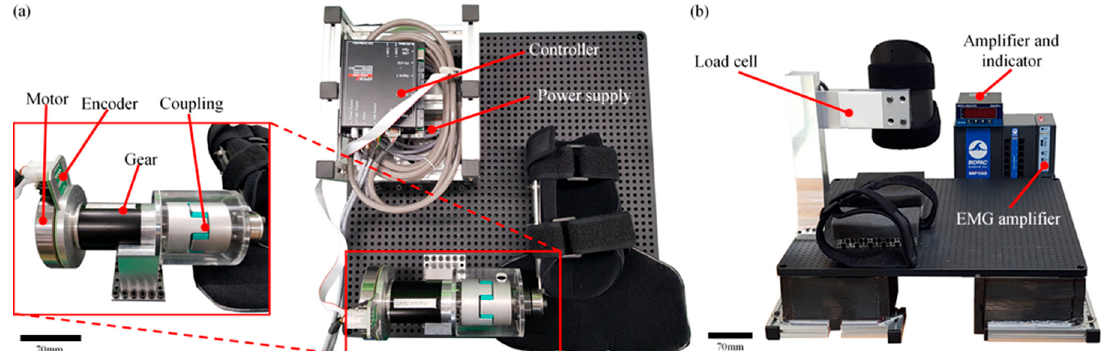
Figure 1. ( a ) The continuous passive motion mirror therapy (CPM − MT) system comprises coupling, gear, motor, encoder, controller, and power supply. ( b ) The muscle fatigue measurement system comprises load cell, load cell amplifier, indicator, and electromyogram (EMG) amplifier.